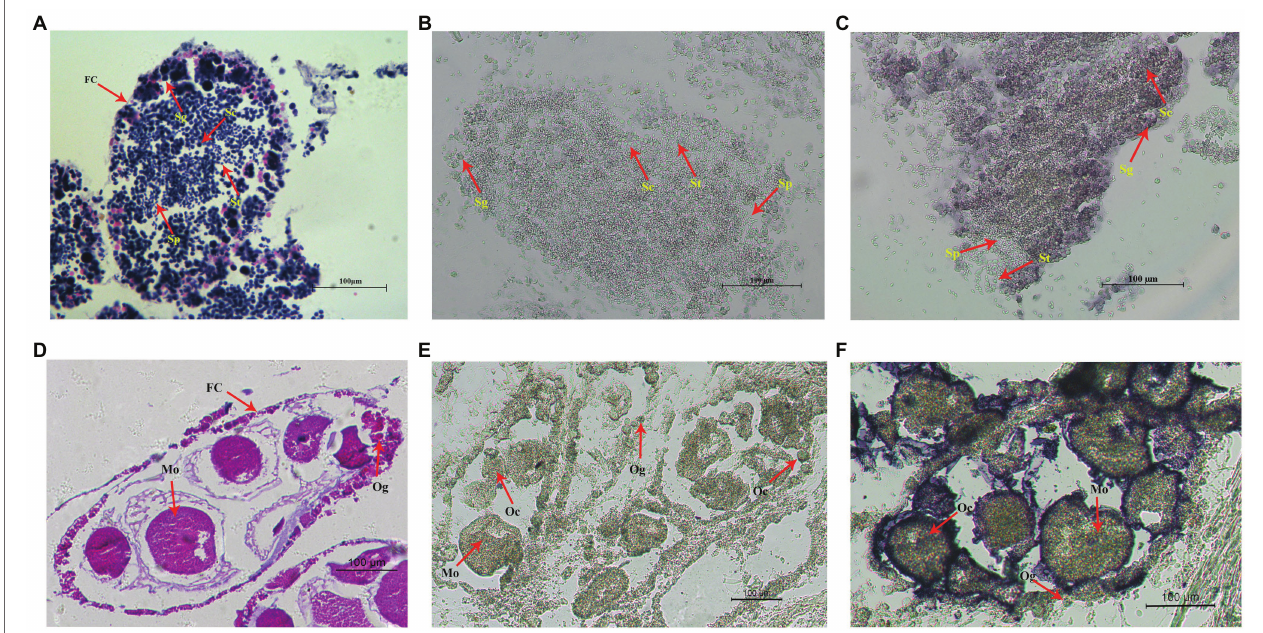
FIGURE 6 | In situ hybridization of Hctra2 gene in testes and ovaries in H. cumingii . (A) testes stained with HE. (B) Male control group. The sense probes acting on testes. (C) Male experience group. The antisense probes acting on testes. (D) Ovaries stained with HE. (E) Female control group. The sense probes acting on ovaries. (F) Female experience group. The antisense probes acting on ovaries. Fc, follicles; Sg, spermatogonia; Sc, spermatocyte; St, spermatid; Sp, sperm; Og, oogonium; Oc, oocyte; and Mo, mature